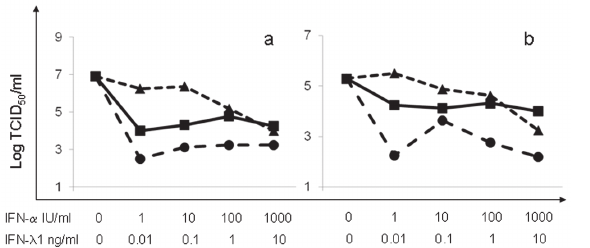
Fig 1. Dose-dependent inhibition of CCHFV replication by recombinant IFN- α , IFN- λ 1 and IFN- α +IFN- λ 1. A549 (a) and HuH7 cells (b) were treated for 1 day with increasing amounts of either IFN type, alone or in combination, then infected with CCHFV at MOI 0.01; infectious virus yield was measured after overnight incubation. One out of three experiments is shown. Dotted lines: IFN- α ( ● ) or IFN- λ 1 ( ▲ ) used alone; continuous line: IFN- α and IFN- λ 1 ( ■ ) used in combination.